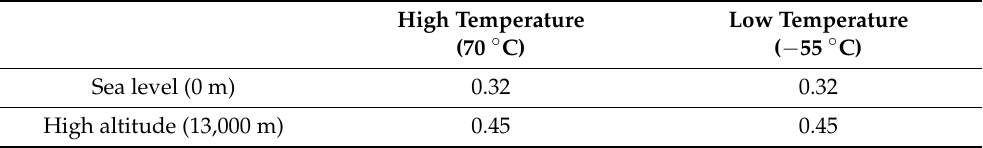
Table 8. Flow rates under different operating conditions (unit: m 3 /s).